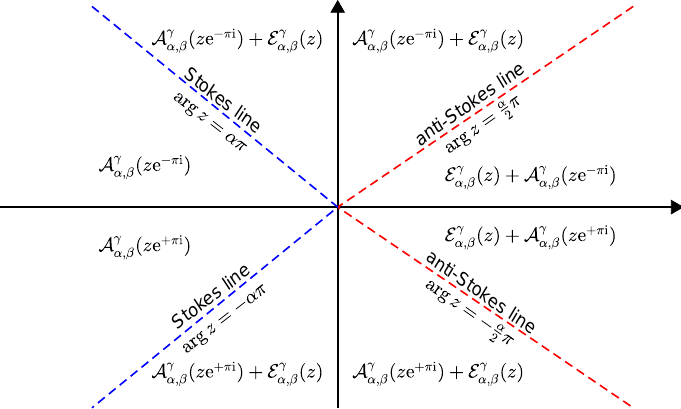
Figure 1. Asymptotic behavior of the Prabhakar function in the complex